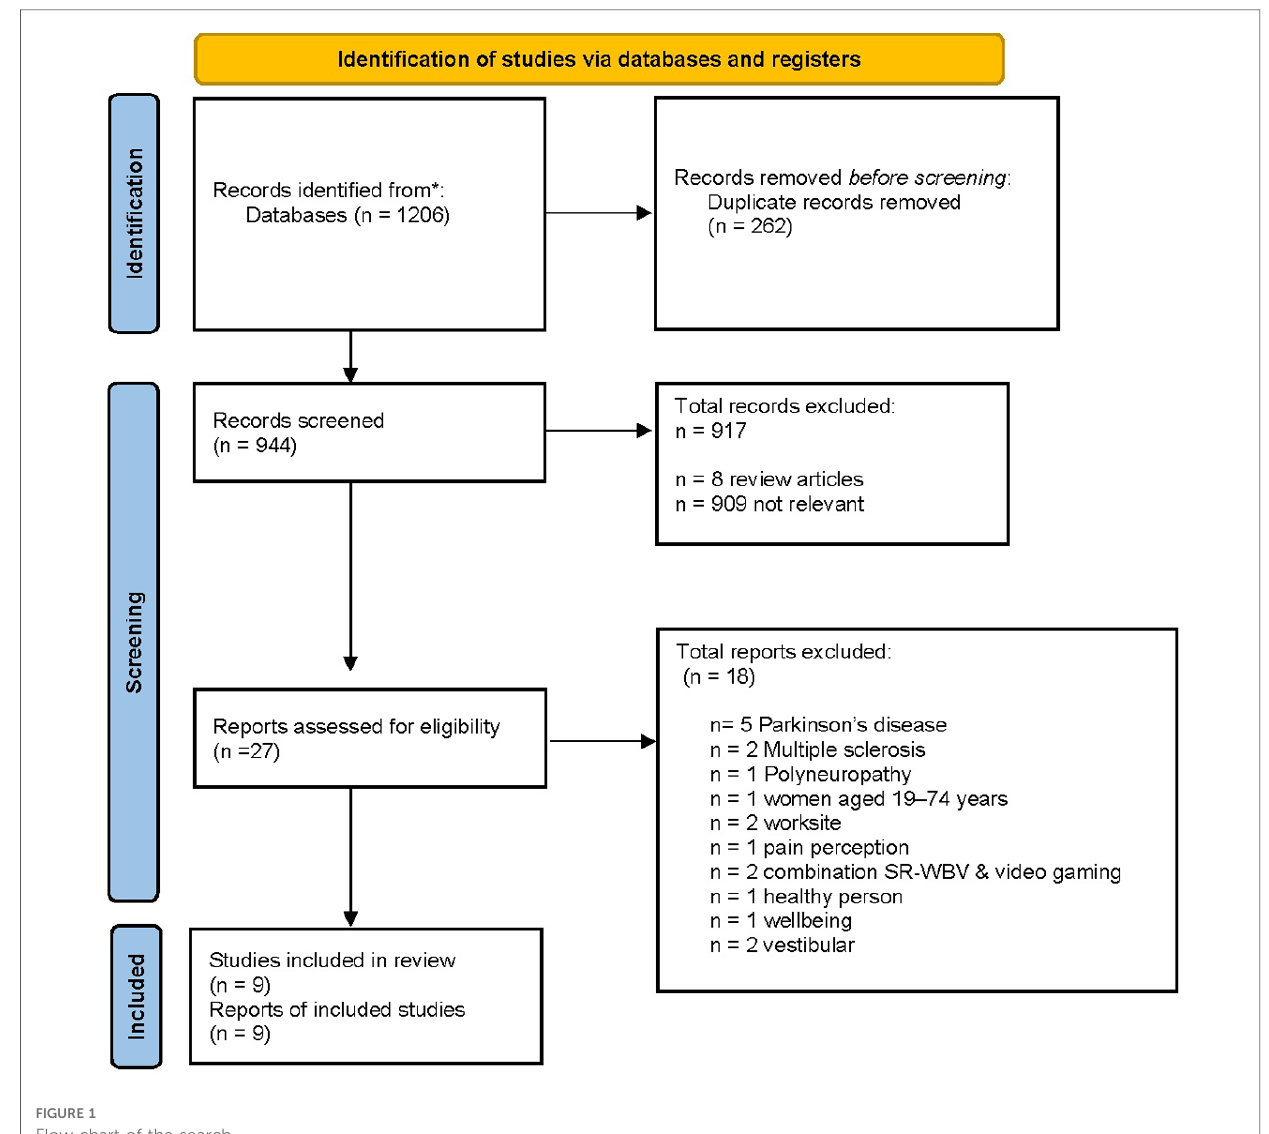
FIGURE 1 Flow chart of the